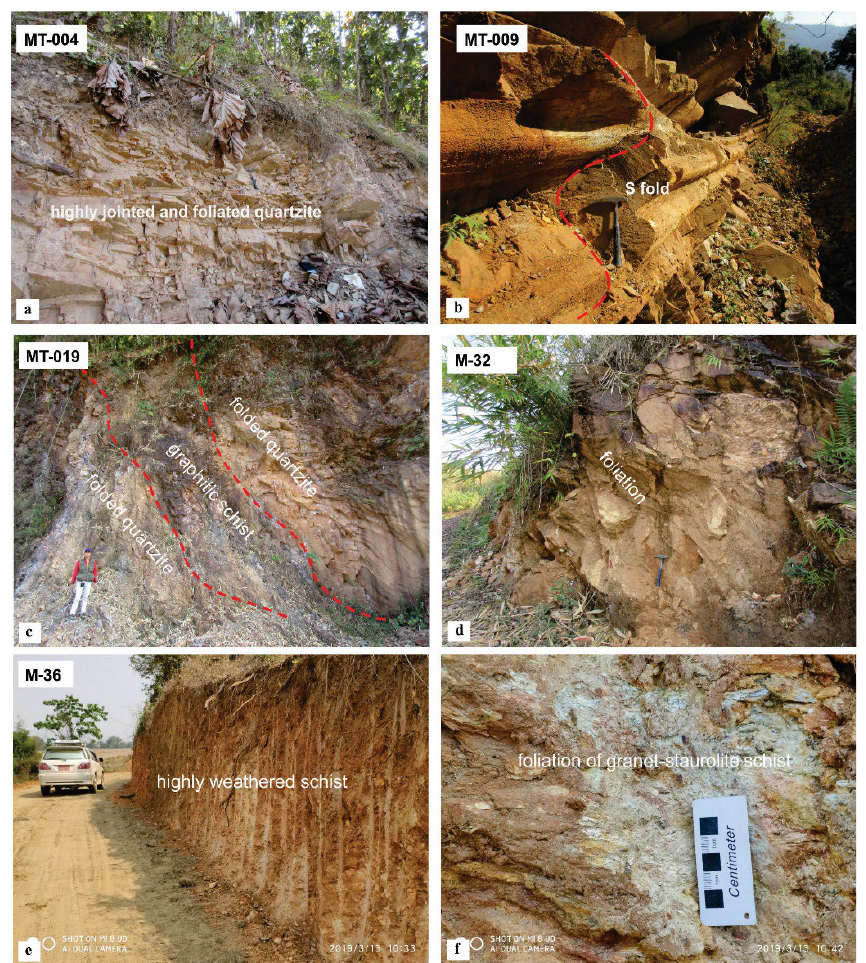
Figure 2. Selected quartzite sample outcrops within the Katha-Gangaw range Mesozoic to Cenozoic period. ( a ) Highly jointed micaceous quartzites in the Tigyaing-Katha area, ( b ) quartzite S-fold trending 195/52, located northeast of Nabar, ( c ) graphite schists are intercalated between thick bedded and folded quartzite located at the south-middle part of the Katha-Gangaw range, and the red lines show the foliation trace of quartzite and graphite schist. ( d ) Quartzite exposed east of Mohgyin area, and ( e , f ) garnet–staurolite schist exposed east of the Pinbaw area in the northern part of the Katha-Gangaw range with their foliation structures.